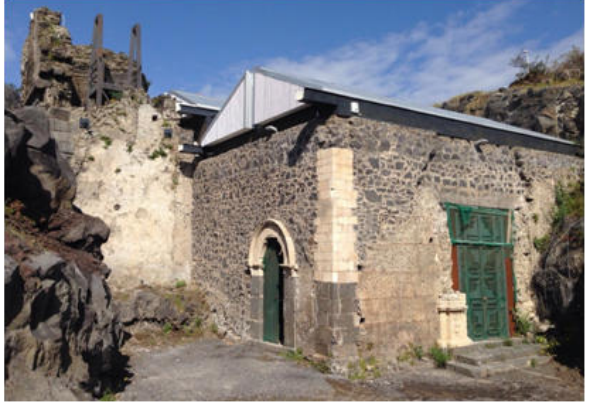
Figure 4. Main and lateral entrance to the church